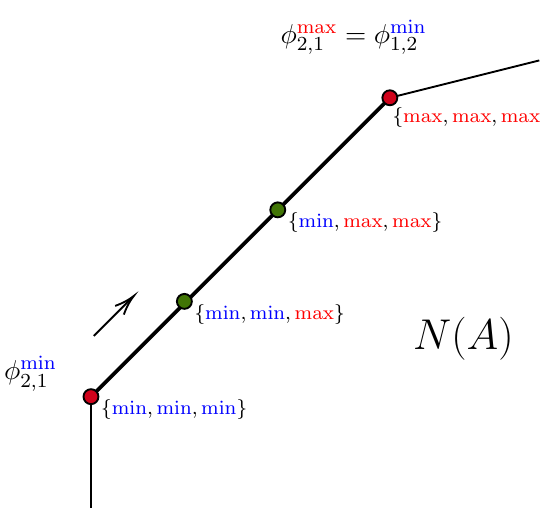
Figure 19 . The ( x; y )-projection of (cid:30) 2 ; 1 onto the edge of N ( A ) gives the four nodes, and the min/max